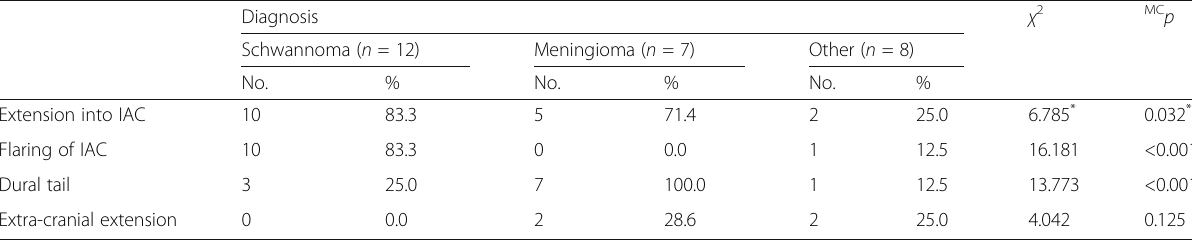
χ 2 chi-square test, MC Monte Carlo p: p value for association between different categories *Statistically significant at p ≤